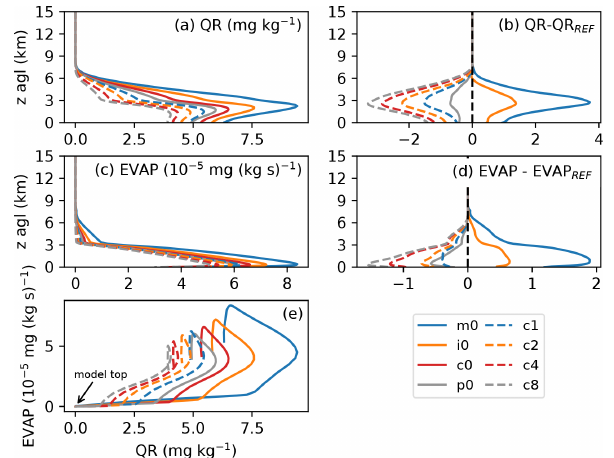
Figure 10. Vertical profiles of spatiotemporal averages of rain water content (QR) and evaporation (EVAP) on 1 July 2009. Panel (e) displays the correlation between EVAP and QR through- out the atmosphere with the origin corresponding to the highest model